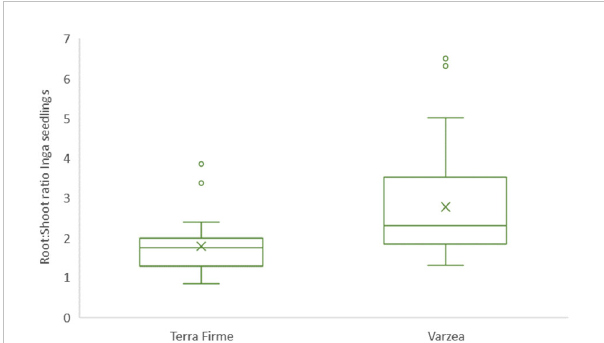
FIGURE 2 Boxplots indicating shoot:root ratio of Inga sp. seedlings collected in terra fi rme and va ́ rzea forest sites. Seedlings were collected during February 2020 at the Tiputini Biodiversity Station in Ecuador. In each box plot, data is plotted as the median (midline) and percentiles (box, 25th and 75th percentiles), the whiskers and individual points (outliers) represent all values within and above 1.5 times the interquartile range, respectively. Additionally, means were plotted as “ X ”